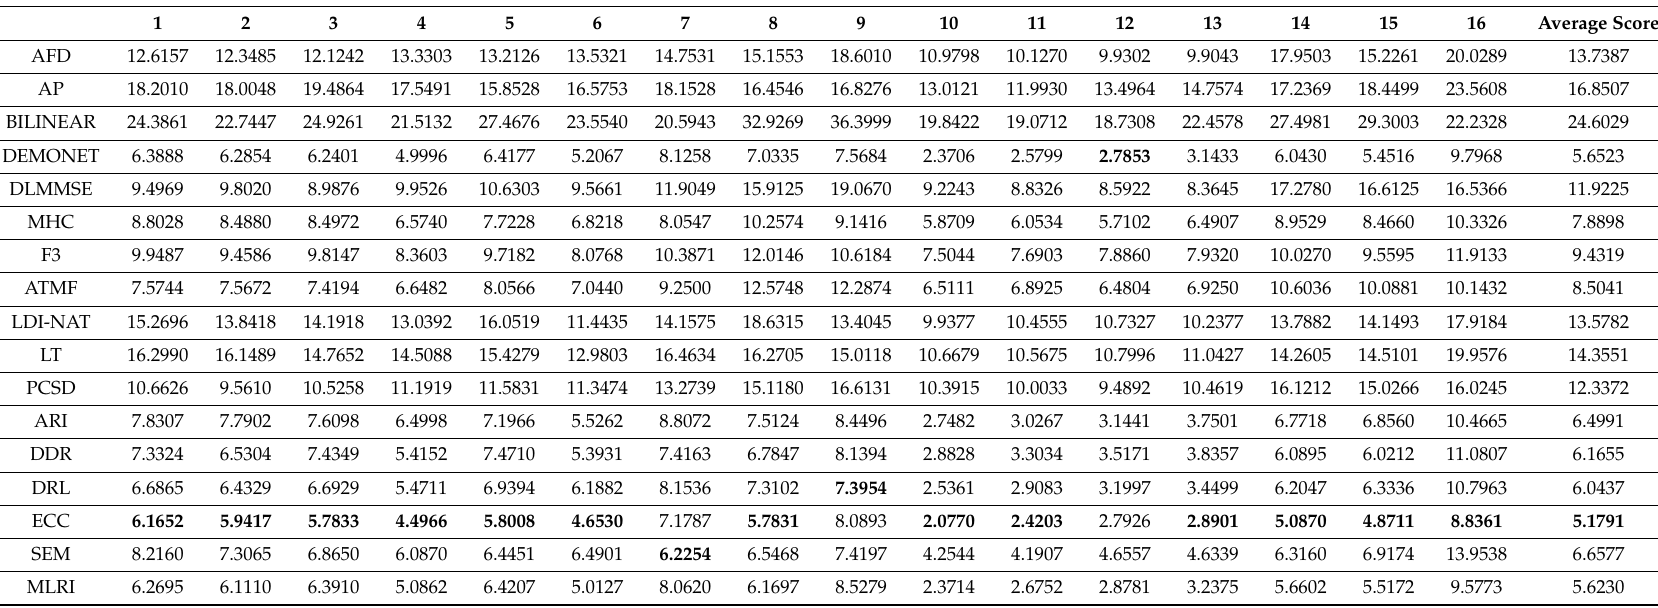
Table 1. Summary of Natural Image Quality Evaluator (NIQE) scores (lower means better). Sixteen left images: Red